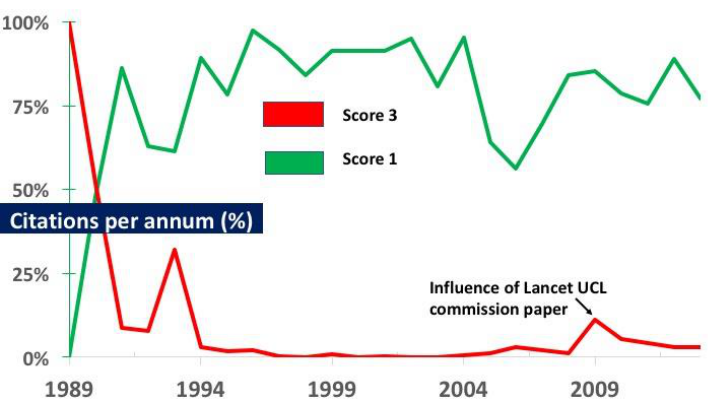
Figure 3. The proportion of citations each year for papers scored as one and three. Since 1991 most citations have been for papers scored as 1. The Lancet UCL paper published in 2009 [11] led to a resurgence of citations for papers scored as 3, but this effect declined. Three individual papers, each scored as two (published in 2005, 2006 and 2007), were disproportionately cited. In each year at least some papers scored two or three, but their proportion of citations fell steeply after the first quintile. In 2003 no paper was scored as three, and for almost a decade (1997–2005 inclusive) virtually no papers scored as three were cited.